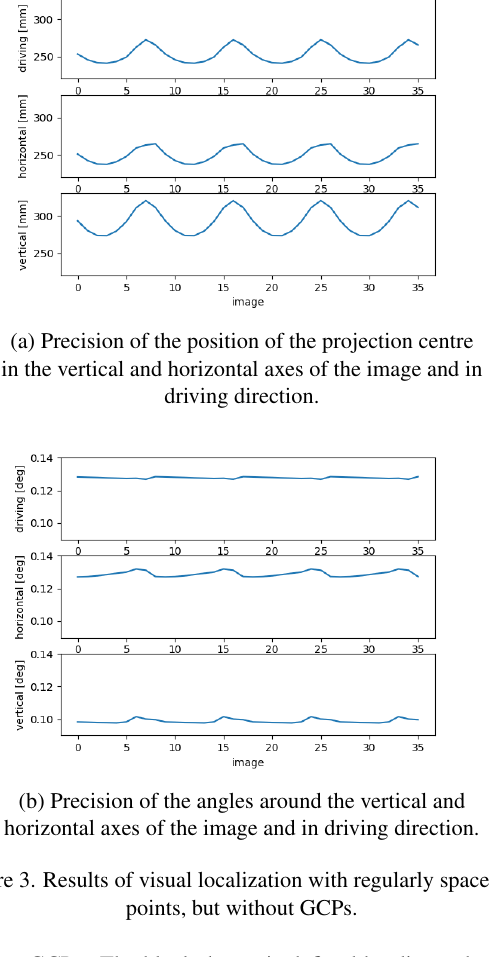
Figure 3. Results of visual localization with regularly spaced tie points, but without